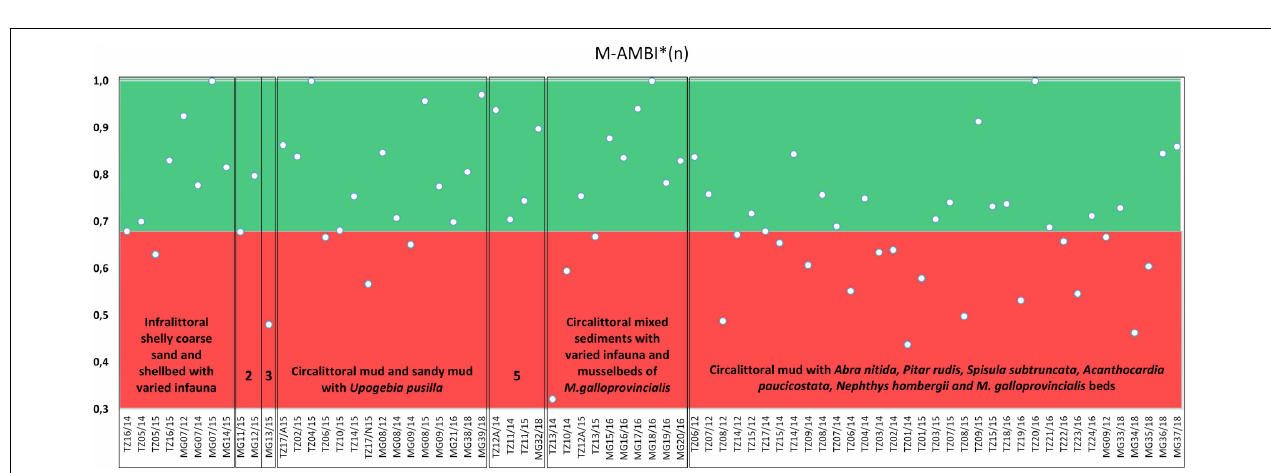
FIGURE 7 | Contour maps showing the variation in (A) the number of macrozoobenthic taxa, (B) their mean density and (C) mean biomass in the Mangalia submarine Sulfur springs MPA, based on samples (round symbols) collected between 2012 and 2018.